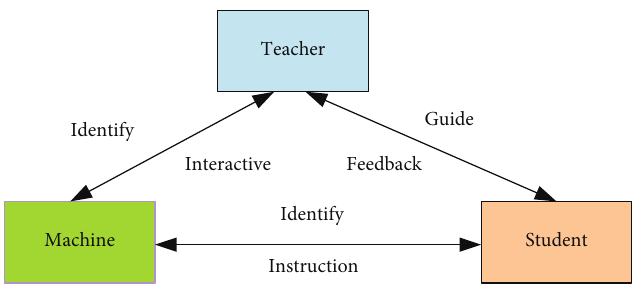
Figure 1: Schematic diagram of teacher, machine, and student